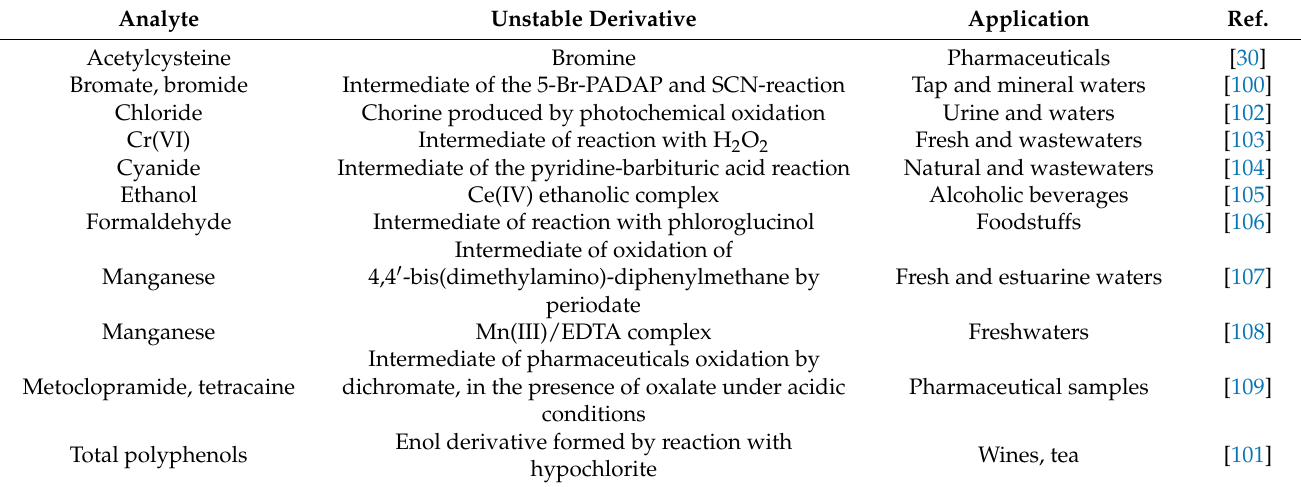
Table 2. Illustrative examples of flow-based procedures exploiting unstable